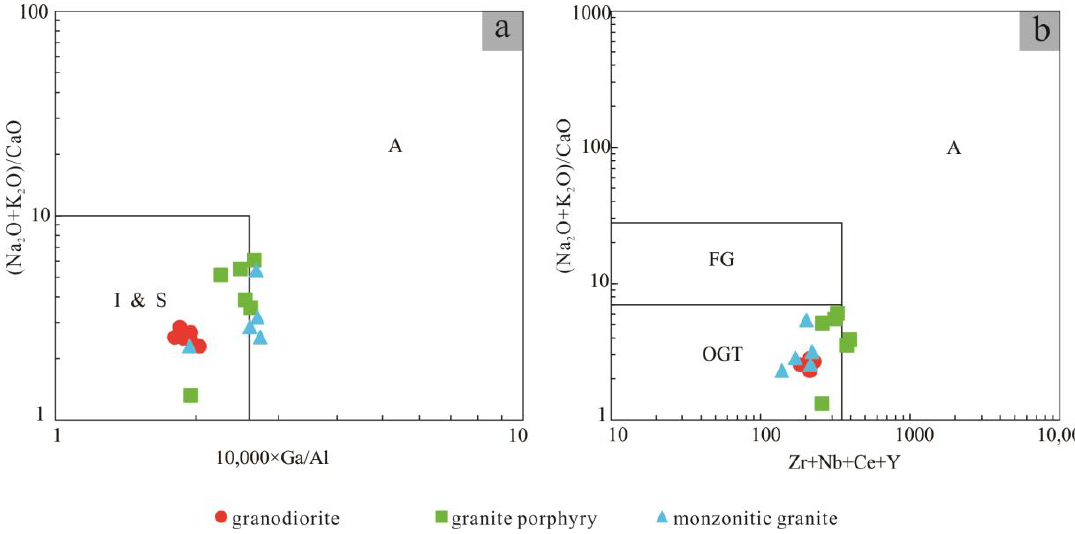
Figure 8. ( a ) (Na 2 O + K 2 O)/Ca − (10,000 × Ga/Al) and ( b ) (Na 2 O + K 2 O)/CaO − (Zr + Nb + Ce + Y) diagrams for Hutouya granites and crystal tuff (FG–fractionated granites; OGT–unfractionated granites; after [60]).